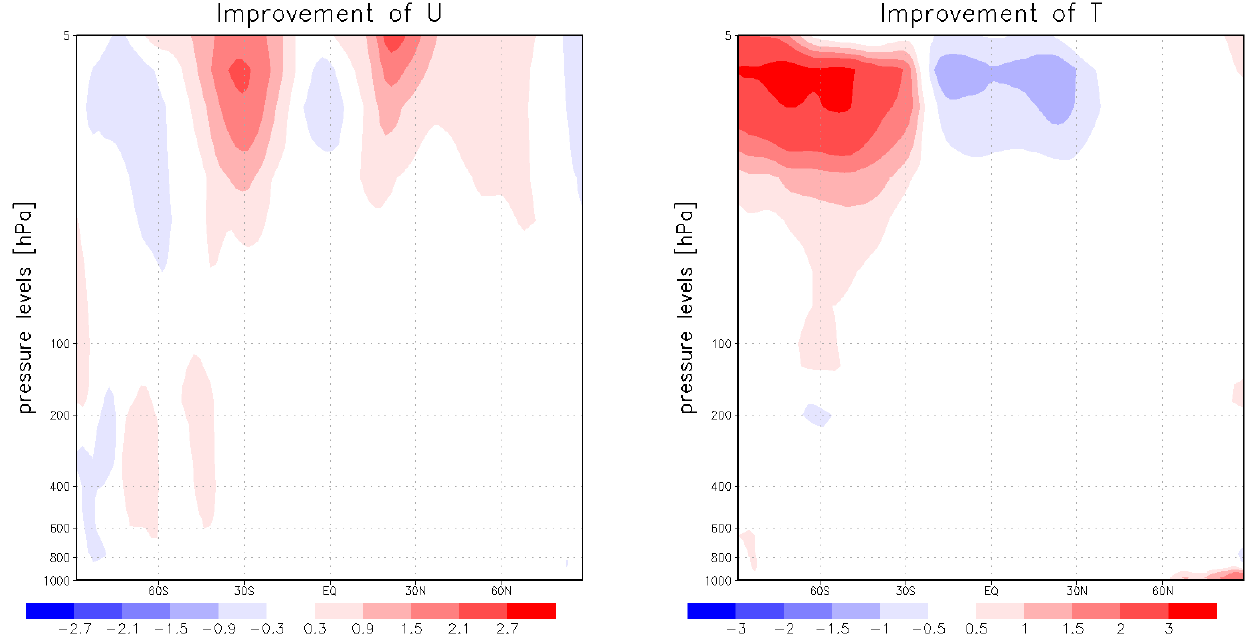
Figure 11. Vertical cross section of zonally averaged improvement of EXP_RO analysis from CTRL_SONDE, toward ERA interim, com- (cid:12) (cid:12) (cid:12) (cid:12) − 1 ) and T (right, unit: K). Positive values indicate analysis of puted by the equation (cid:12) x a sonde − ERA (cid:12) − (cid:12) x a ro − ERA (cid:12) for U (left, unit: ms EXP_RO closer to ERA interim data than CTRL_SONDE and vice versa.